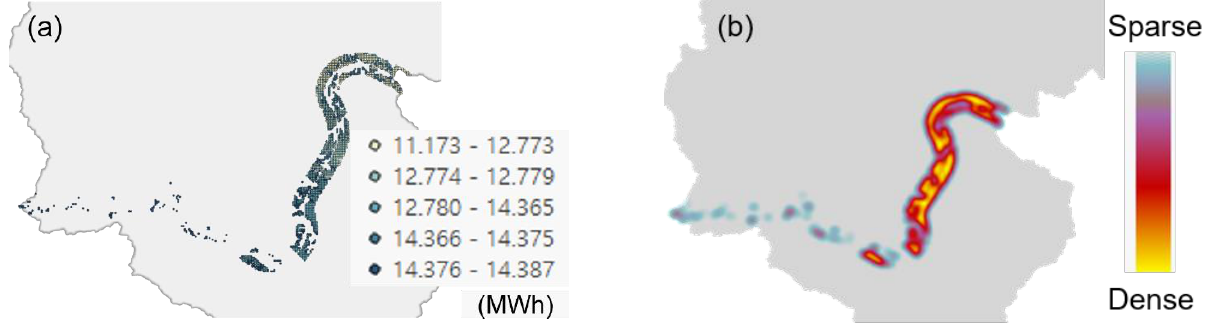
Figure 8. ( a ) Distribution map for energy production trends, and ( b ) heatmap of representative surface of the density in suitable sites for PV-plant installation near highway networks in the case area.